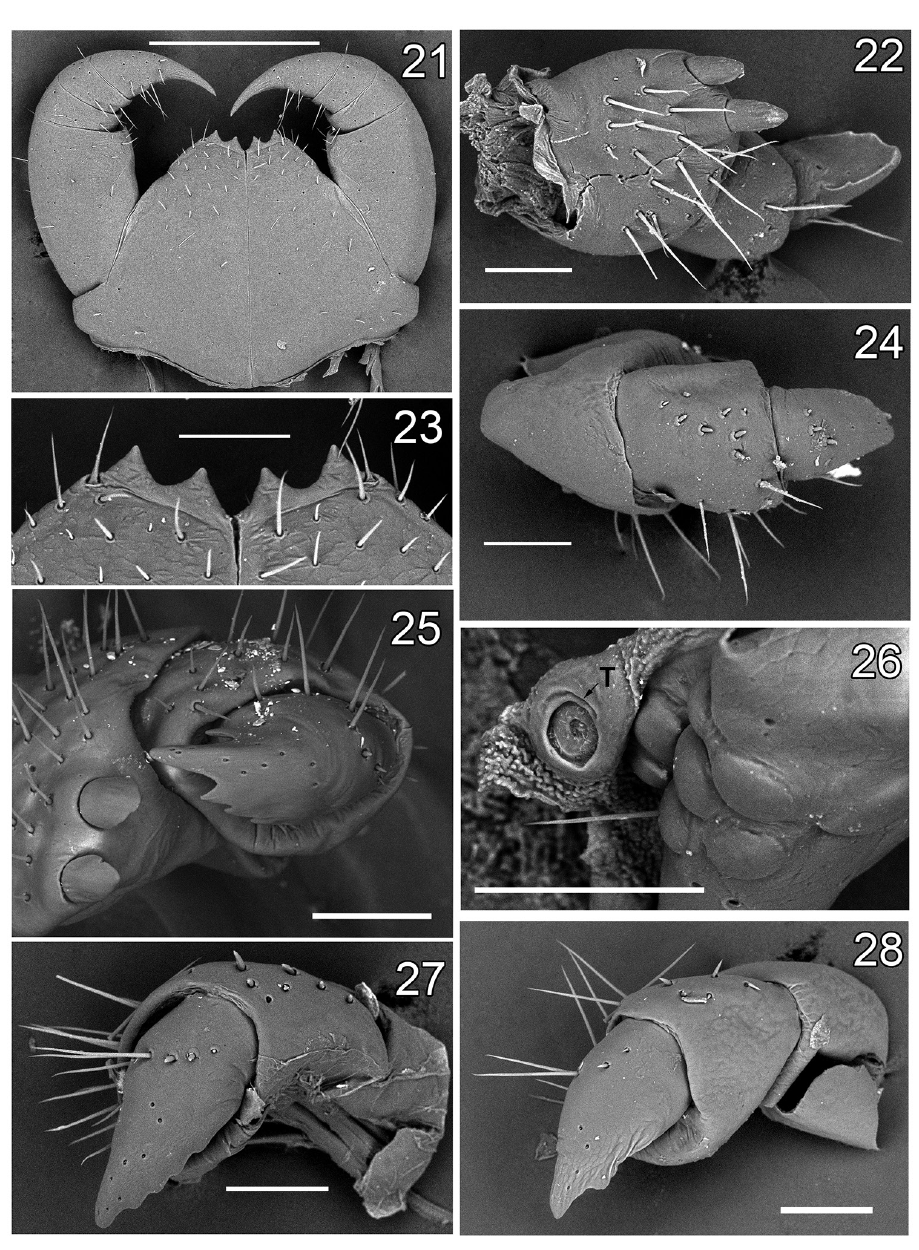
Figures 21–28. Lithobius ( Chinobius ) yuchernovi sp. n., female paratype ( 21–24, 26 ) and non-type females (25, 27–28). 21, 23 forcipule and dental margin of forcipular coxosternite, ventral view 22 go- nopod, ventral view 24 gonopod, dorsal view 25 gonopod, ventrolateral view (Chukotka) 26 ocelli and Tömösváry’s organ, lateral view 27 gonopod, dorsolateral view (Magadan Region) 28 same (Kamchatka Peninsula). Scale bars: 0.5 mm ( 21 ), 0.1 mm ( 22–28